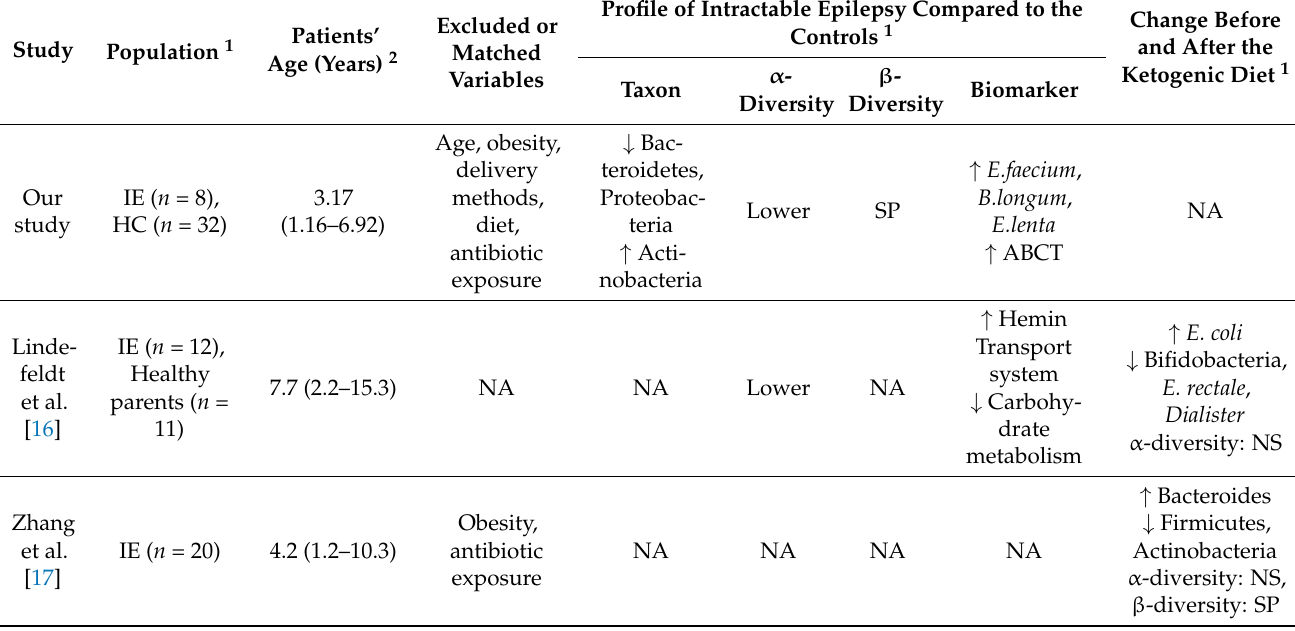
Table 1. Summary of previous studies on the intestinal microbiota in patients with intractable